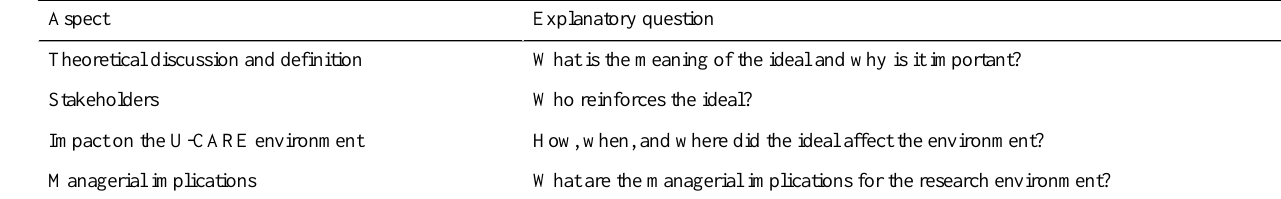
Table 1. A structure to scrutinize ideals in eHealth research.